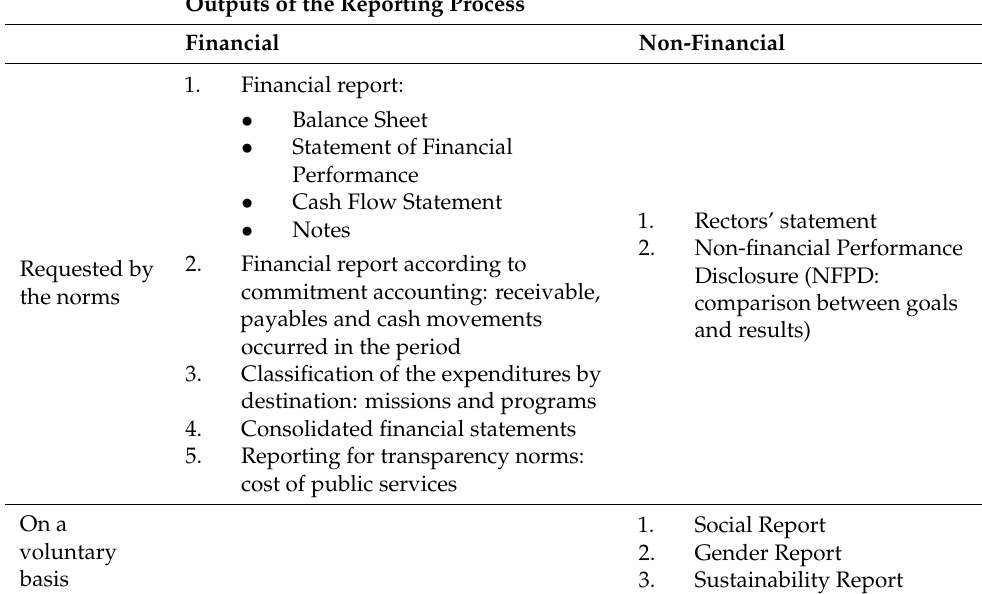
Table 1. Universities’